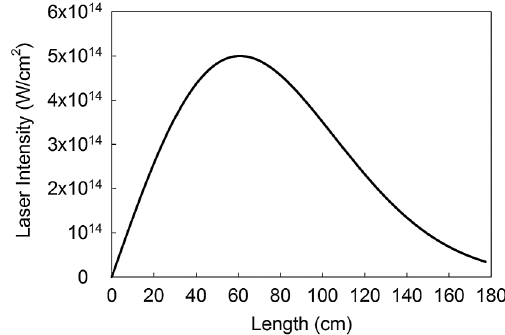
FIG. 9. Plot of the laser intensity as a function of length along the Bessel-beam focus for a peak intensity of 5 (cid:4) 10 14 W = cm 2 .